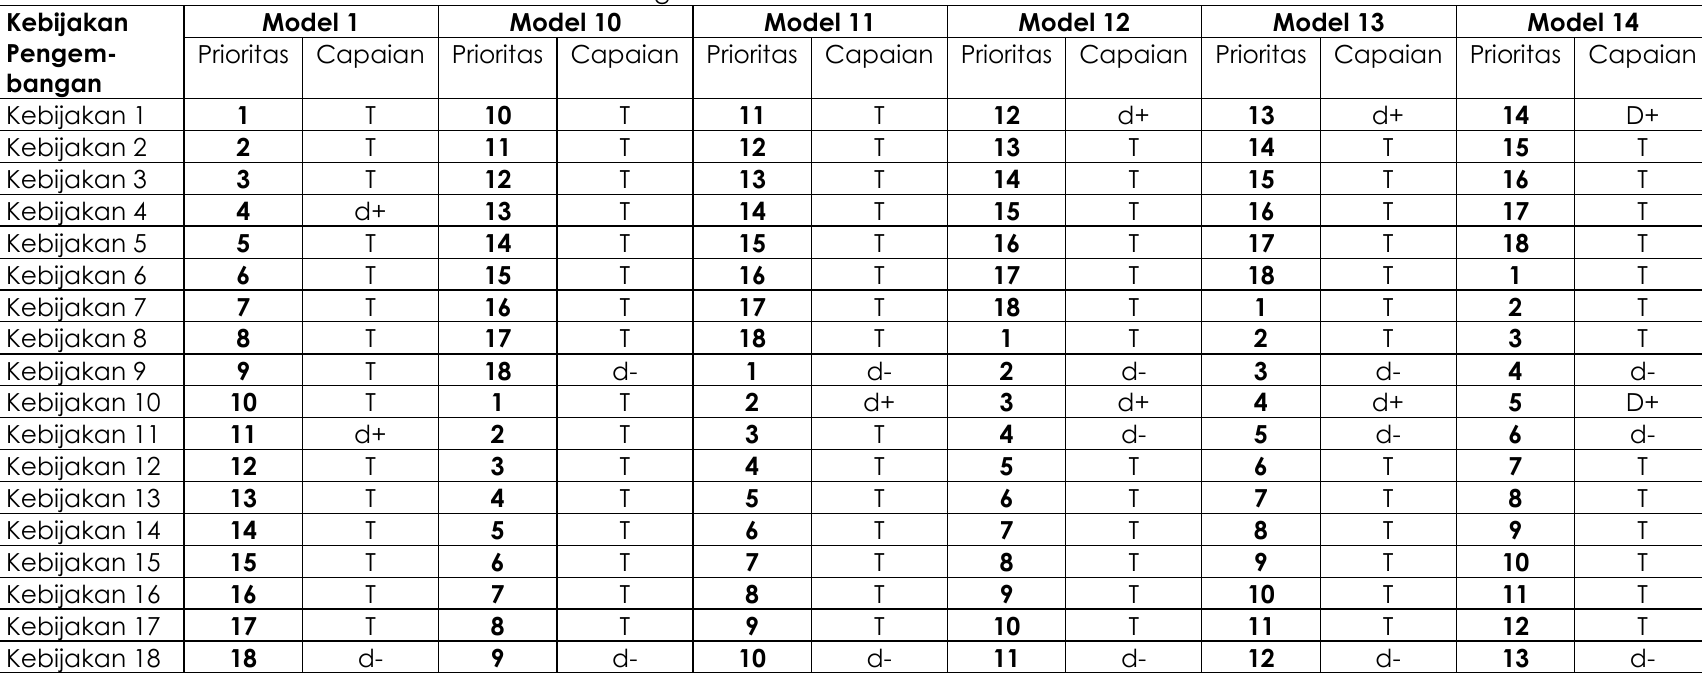
Tabel 3: Analisis Prioritas dan Kendala Pada Model Yang